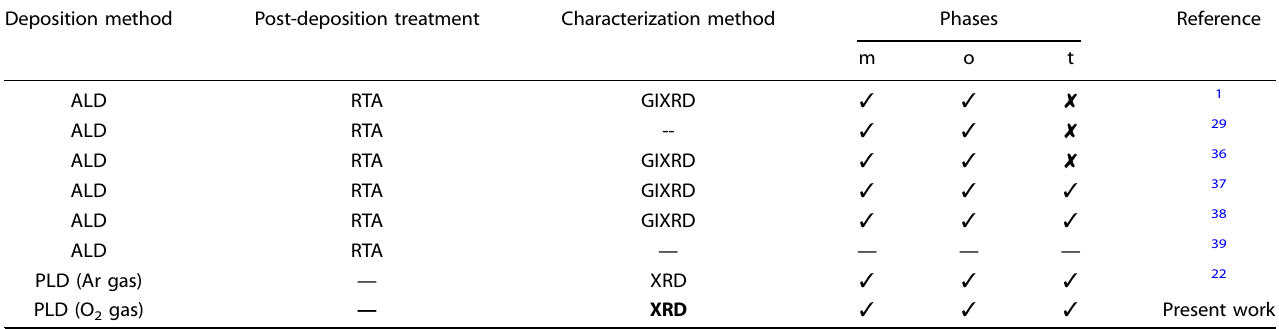
Table 1. Comparison of previous reports of HZO thin fi lms on Si substrate with the present